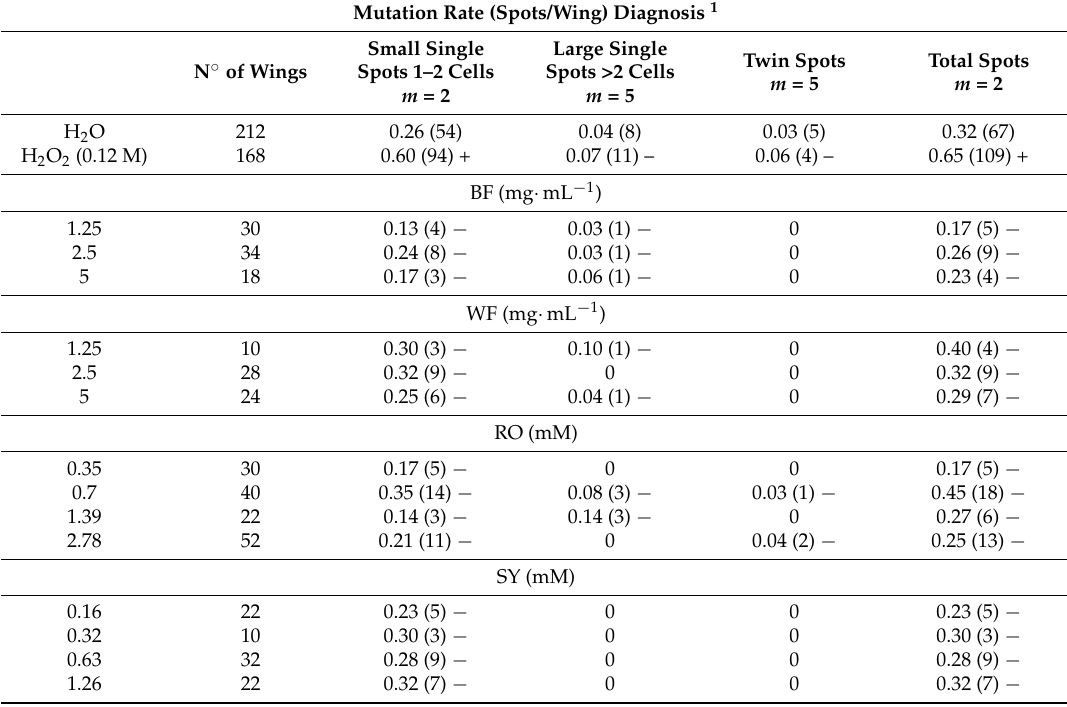
Table 3. Antigenotoxicity of Borago officinalis plant material: blue flowered (BF) and white flowered (WF); and the bioactive compounds: rosmarinic (RO), syringic (SY) and sinapic (SI) acids. Mutation Rate (Spots/Wing) Diagnosis